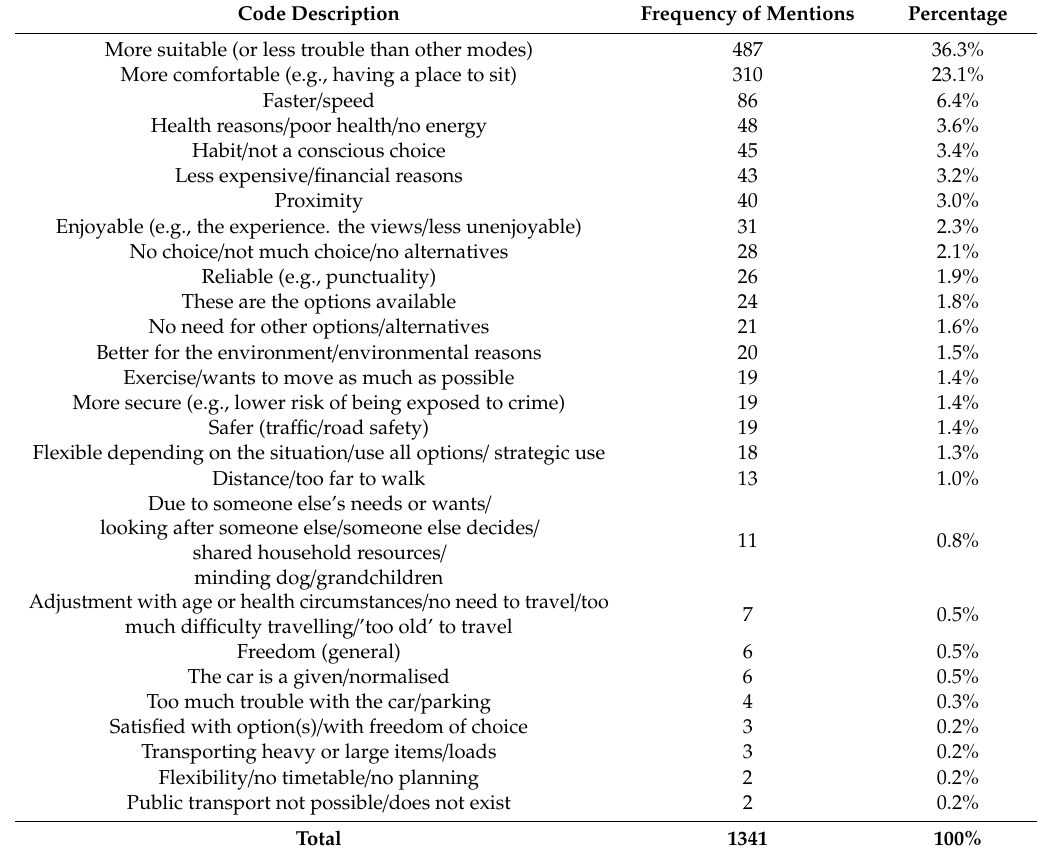
Table 3. Reasons for choosing to use one or several modes over another or other options 1